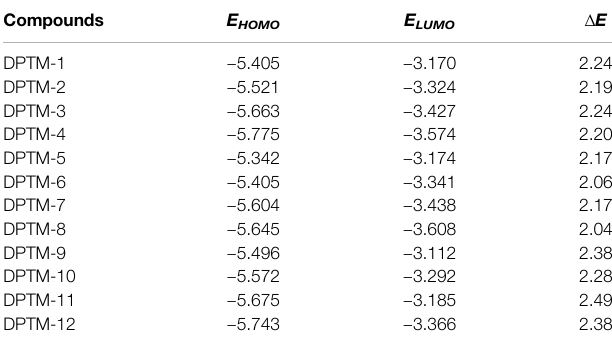
TABLE 1 | The E HOMO , E LUMO , and energy gap ( E LUMO -E HOMO ) of investigated compounds (DPTM-1 to DPTM-12). Compounds E